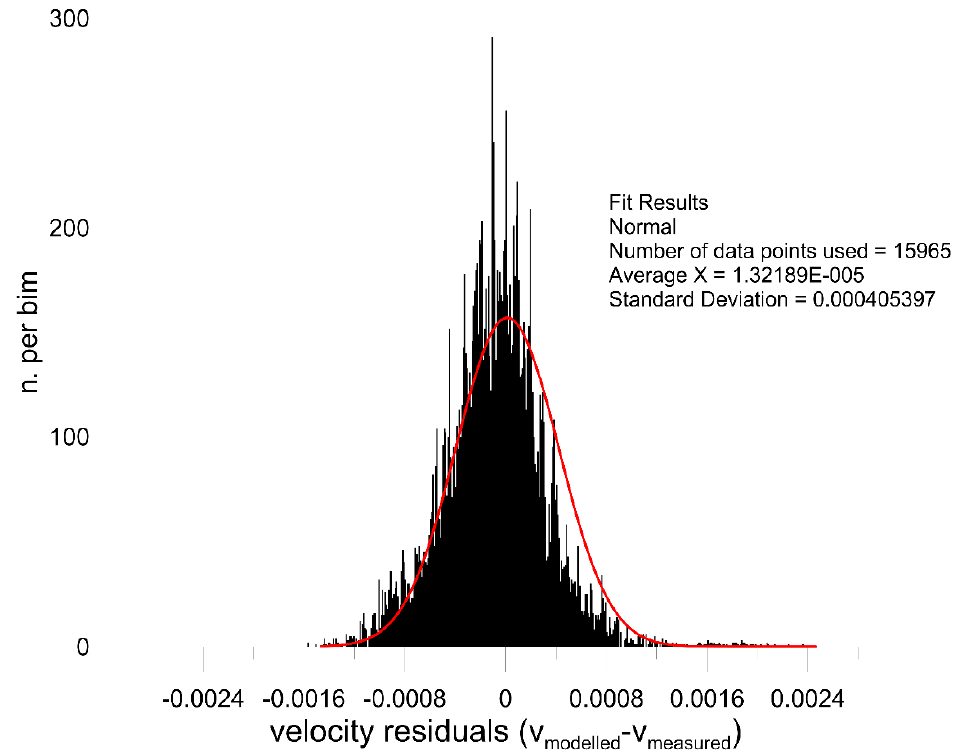
Figure 6. Histograms of the residuals between modelled velocities and actual